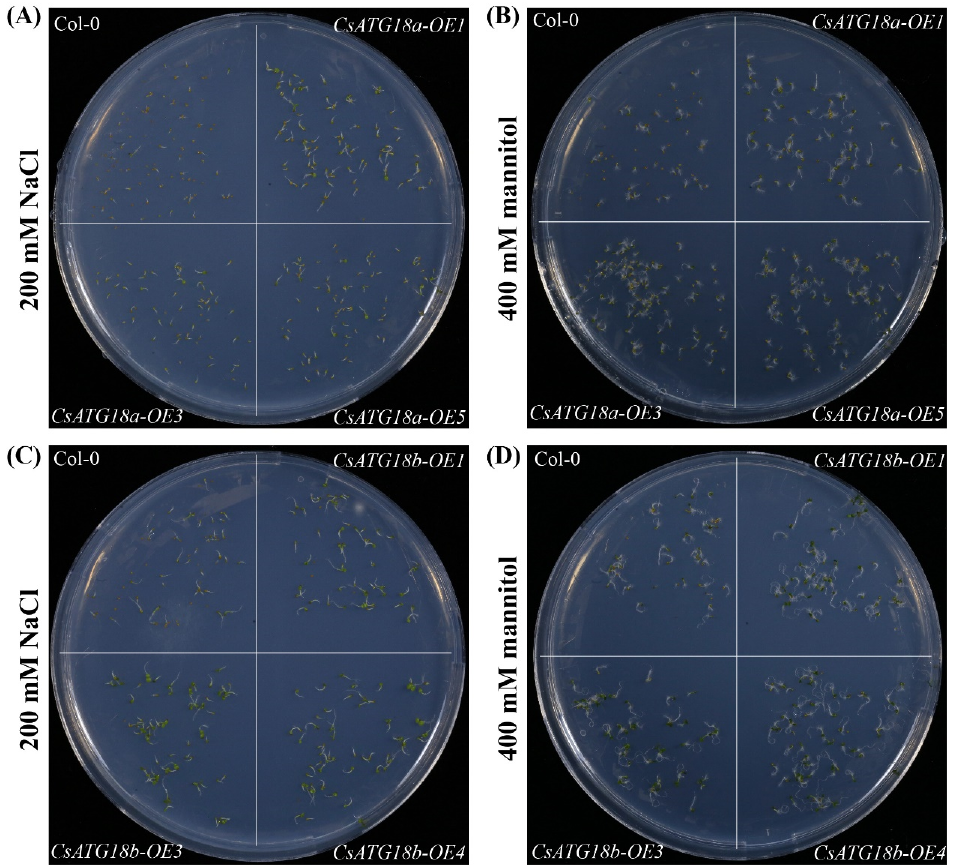
Figure 6. Germination phenotype of CsATG18a - and CsATG18b -overexpressed (OE) lines and wild-type (WT) under NaCl and mannitol stresses. ( A–D ) Representative pictures of three homozygous OE lines (OE1, OE3, and OE5 of CsATG18a , and OE1, OE3, and OE4 of CsATG18b ) and WT (Col-0) of Arabidopsis that germinated on 200 mM NaCl ( A,C ) and 400 mM mannitol ( B,D ) for 7 days. Three independent experiments were performed and the similar phenotype was